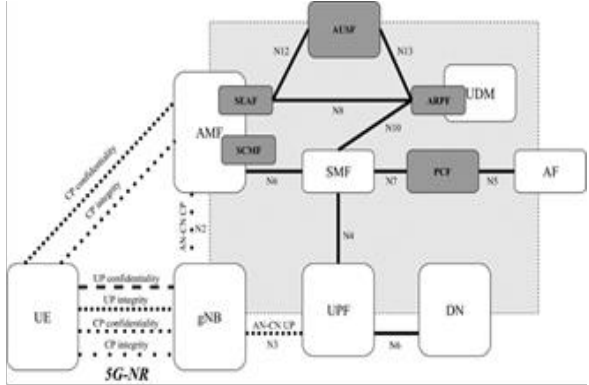
Figure 6. 5G System Architecture